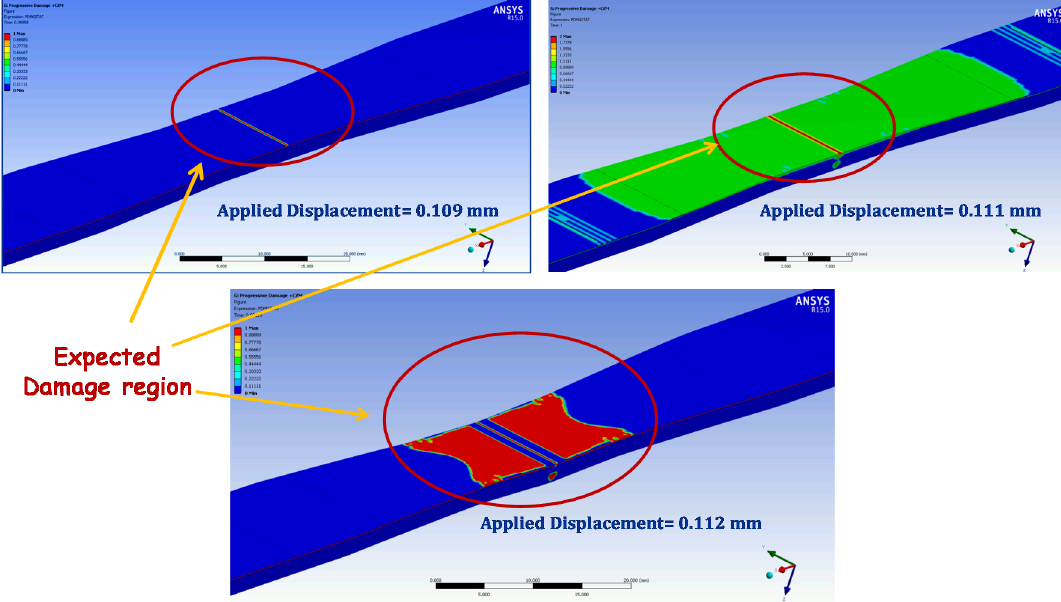
Figure 12. Damage evolution results at various displacement and at 3951.5 N.